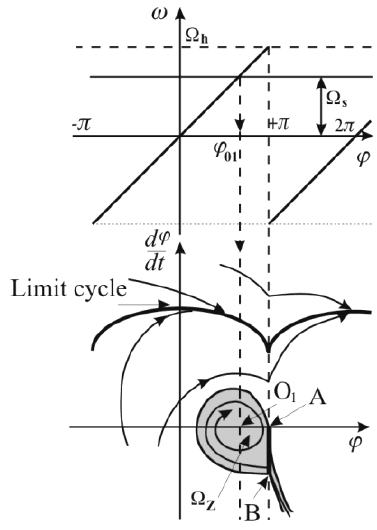
 with containing the target Z